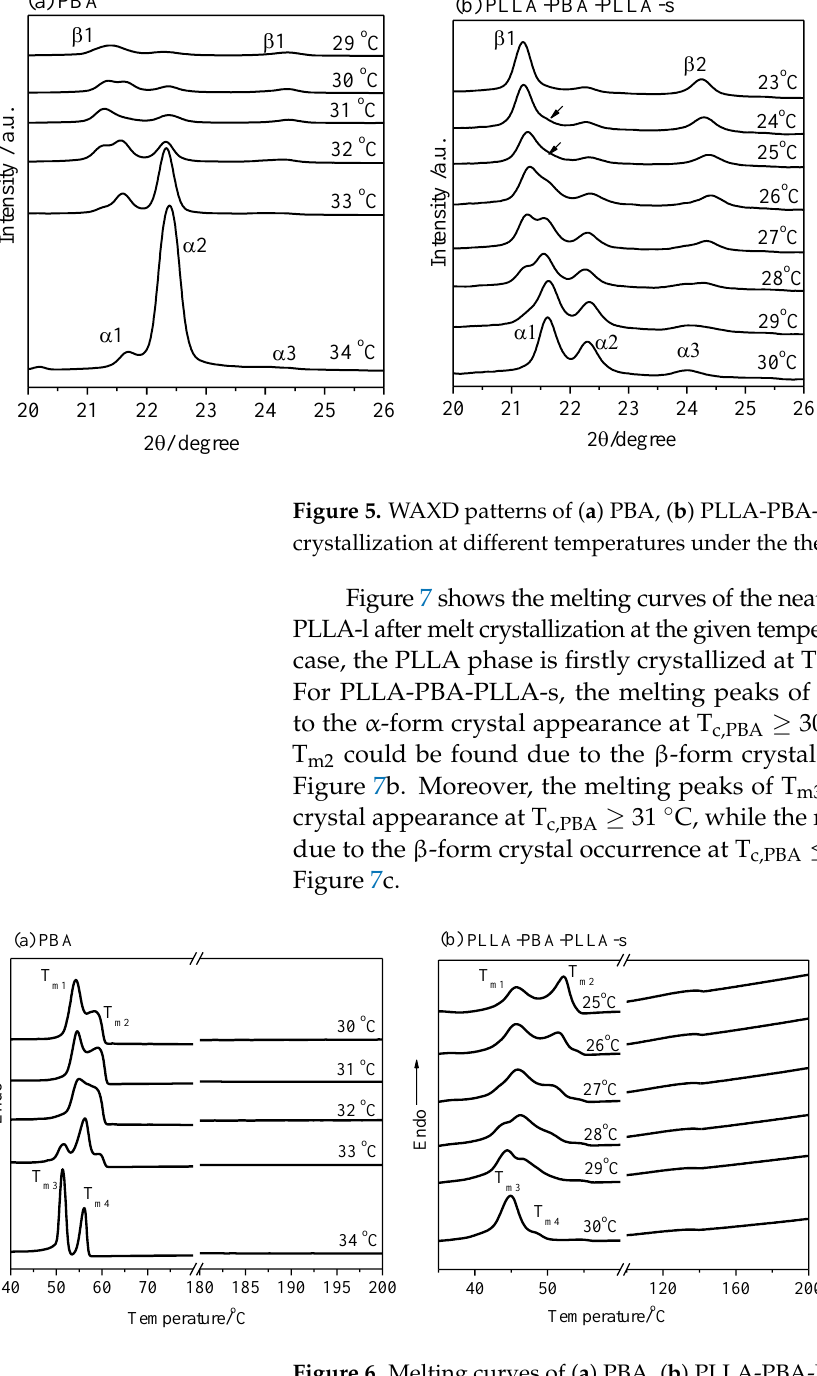
Figure 6. Melting curves of ( a ) PBA, ( b ) PLLA-PBA-PLLA-s, and ( c ) PLLA-PBA-PLLA-l after melt crystallization at a given temperature, and then heating directly from this given temperature at a heating rate of 10 °C/min under the thermal program 1.